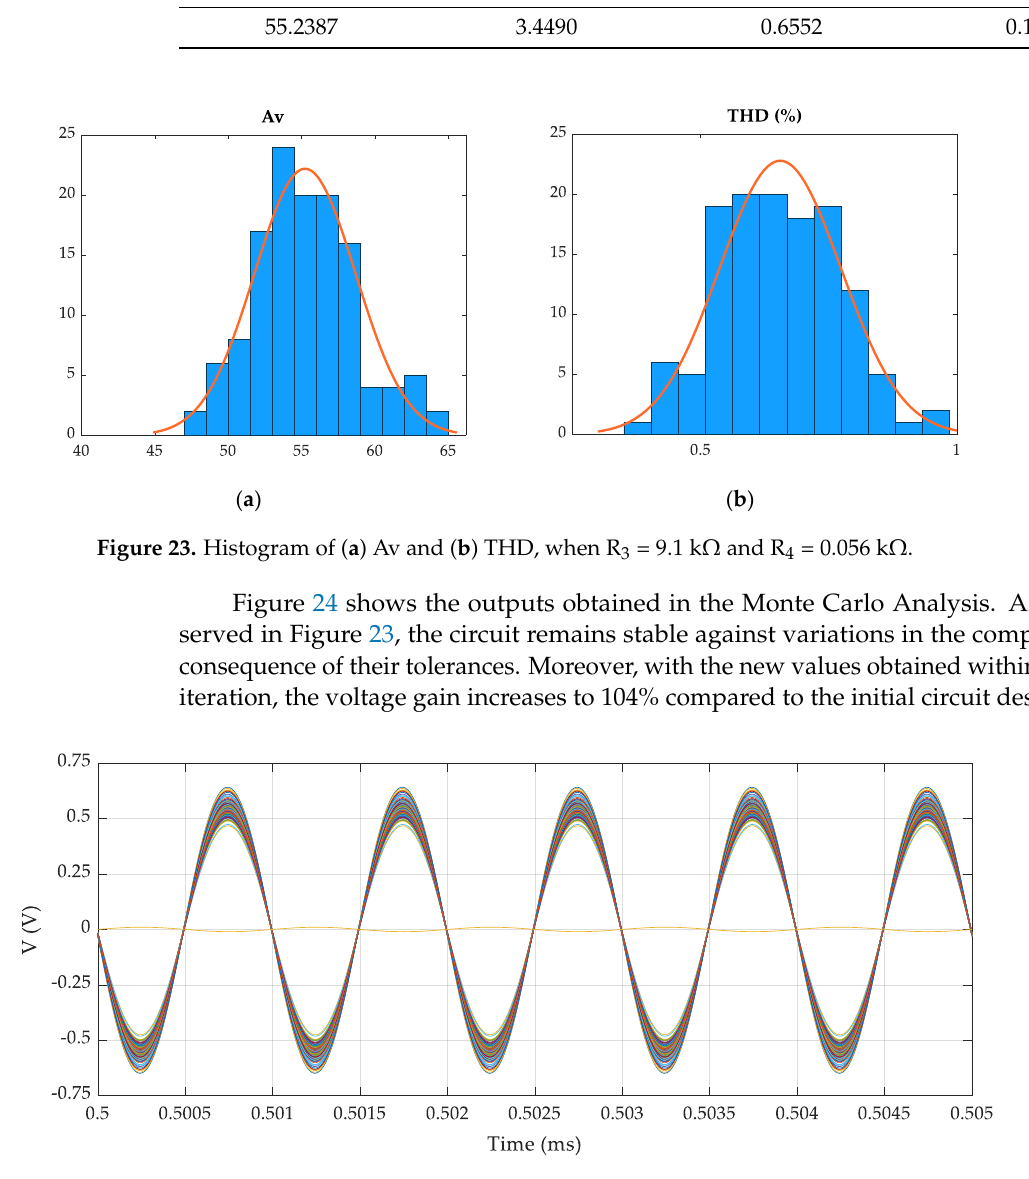
Ω and R Ω (Monte Carlo 3 = 9.1 k 4 = 0.056 k